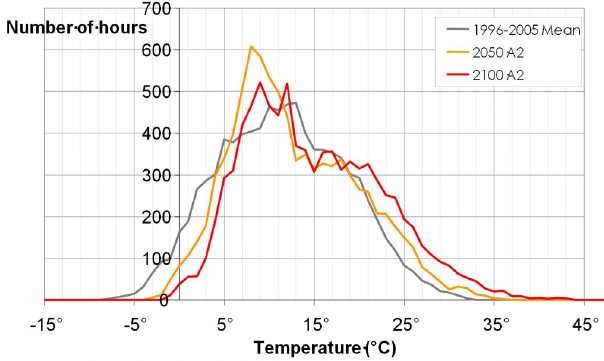
Fig. 3. Annual distribution of the number of hours for the temper- ature for Paris in the case of the scenario A2.